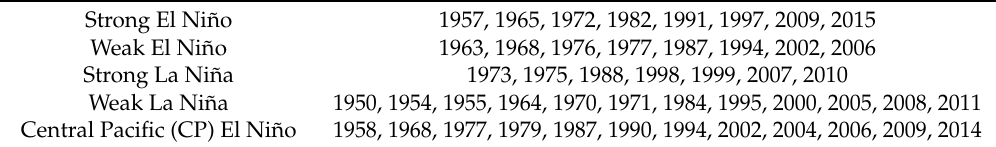
Table 3. Years in which strong and weak ENSO phases developed (Source: Santoso et al.